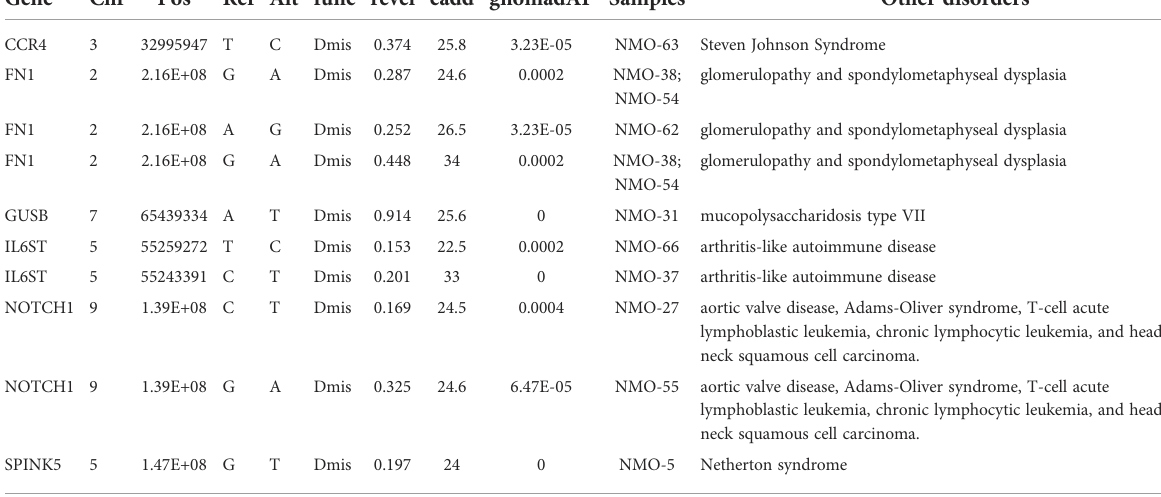
TABLE 2 Selected candidate inherited mutations for NMOSD.